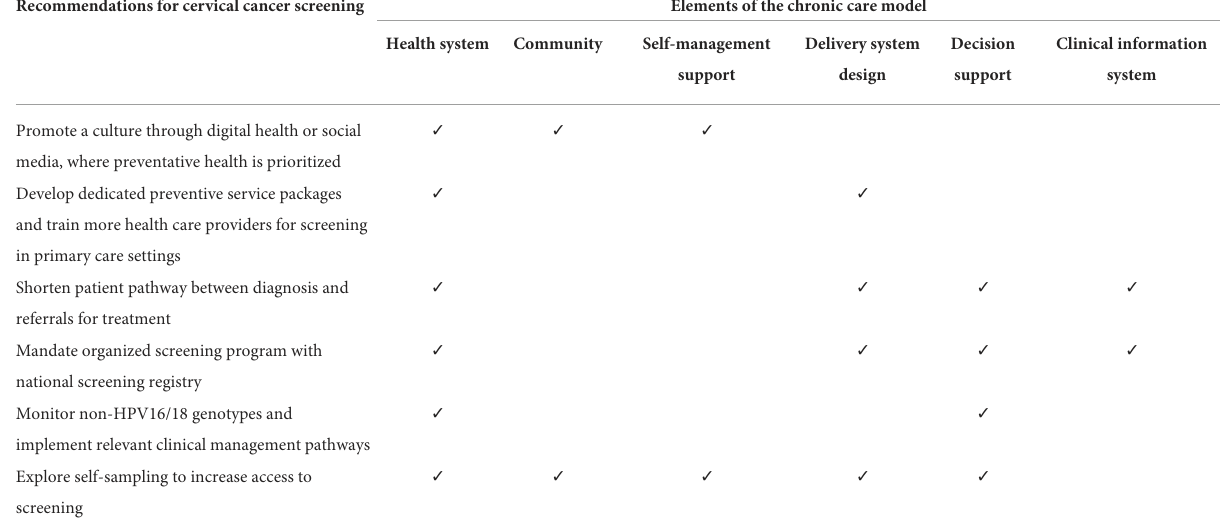
TABLE 4 Recommendations for cervical cancer screening according to the Chronic Care Model